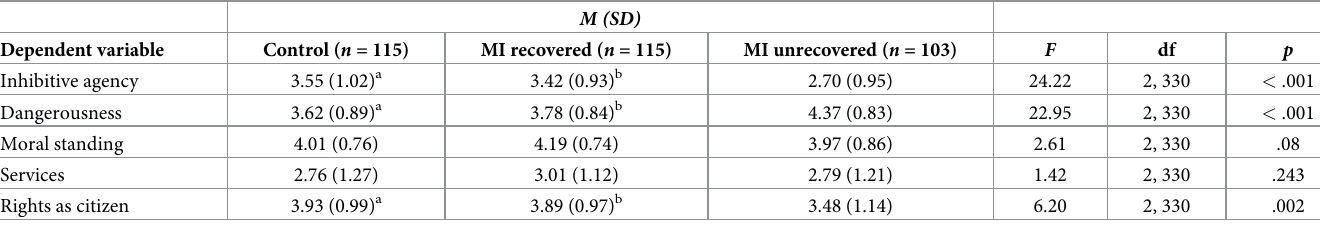
Table 6. Descriptive and inferential statistics for dependent variables after release (Study 2).